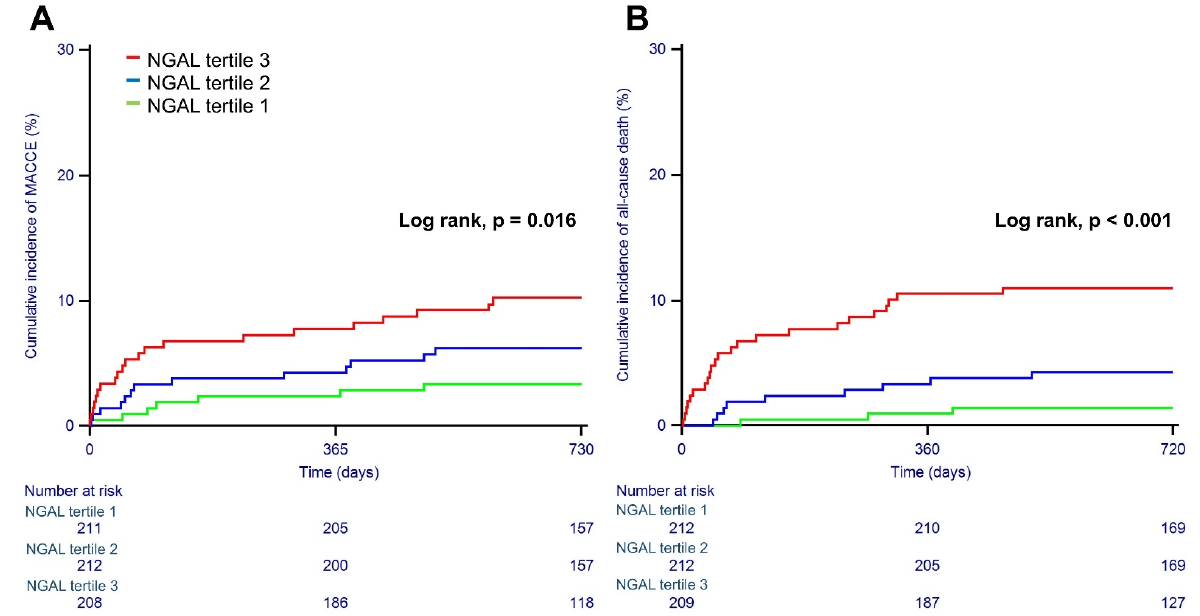
Figure 2. Kaplan ‒ Meier curves for major adverse cardiac and cerebrovascular events ( A ) and all-cause death ( B ) according to tertiles of baseline serum NGAL. Table 4. Hazard ratios of baseline serum NGAL tertiles for MACCEs and all-cause death.